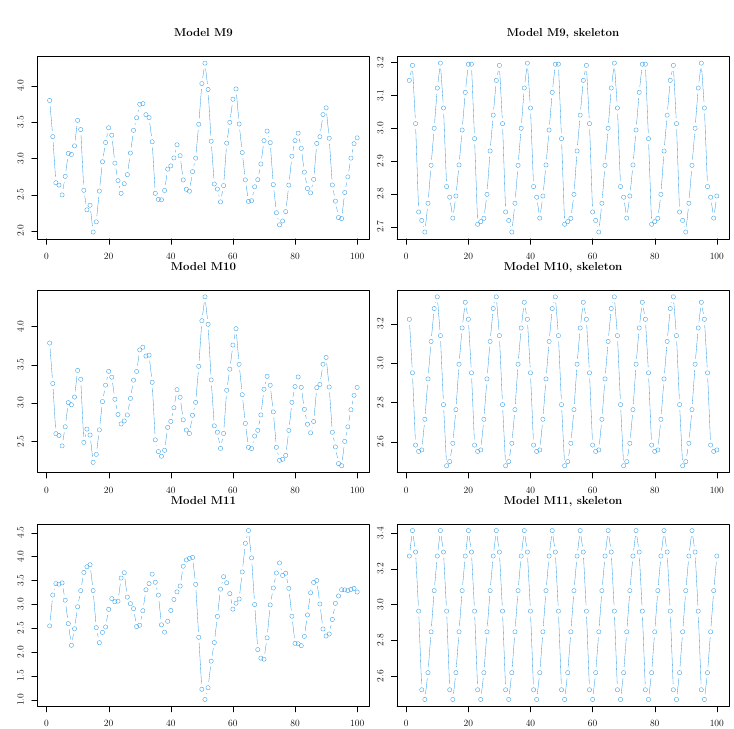
Figure 20 – Time plot of the simulated time series and their skeletons for TARMA models M9 – M11